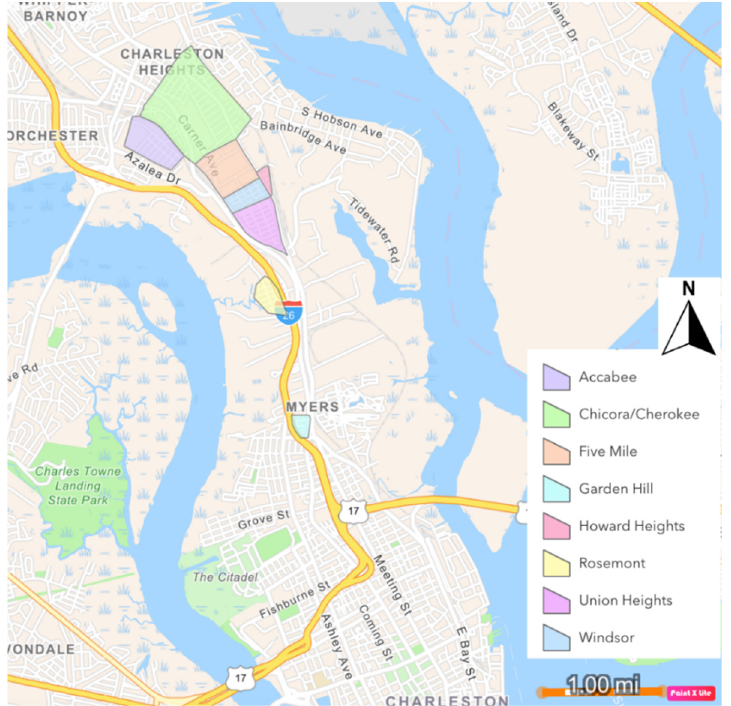
Figure 5. Approximate locations of LAMC communities in the Charleston Neck (digitized from descriptions in LCRT’s NEPA report [17].